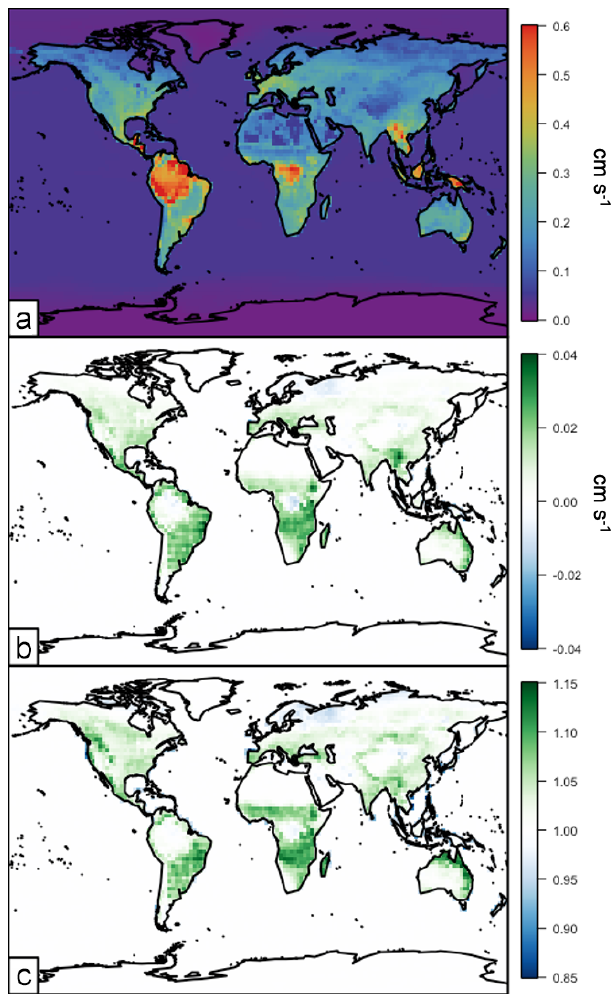
Figure 12. Annual average (2012) ozone dry deposition veloci- ties simulated in GEOS-Chem when driven by the surrogate model canopy physics. Panel (a) shows the annual average dry deposition velocities (cms − 1 ). Panel (b) shows the difference between the sur- rogate model and the base version of simulated dry deposition ve- locities (cms − 1 ). Panel (c) shows the relative difference between the surrogate model and the base version of simulated dry deposi- tion velocities (surrogate–base model).